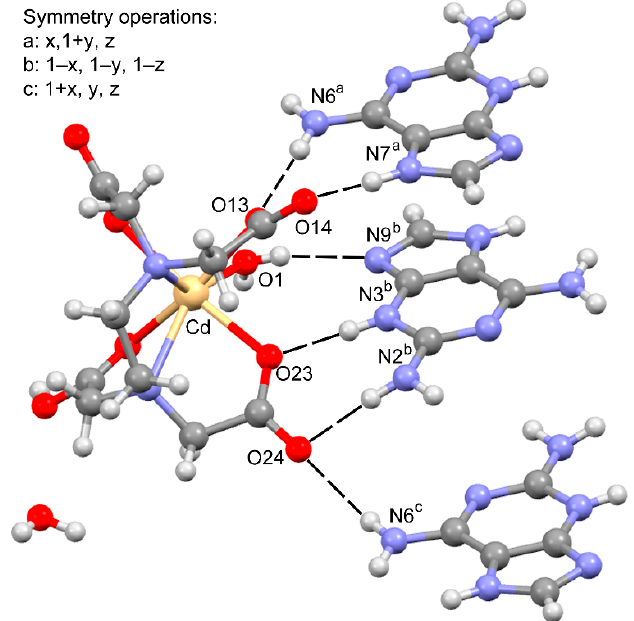
Figure 3. Molecular recognition pattern showing the cooperation of H-bonds between the [Cd(HEDTA)(H 2 O)] – chelate anion and three neighboring H 2 (N3,N7)dap + ions.